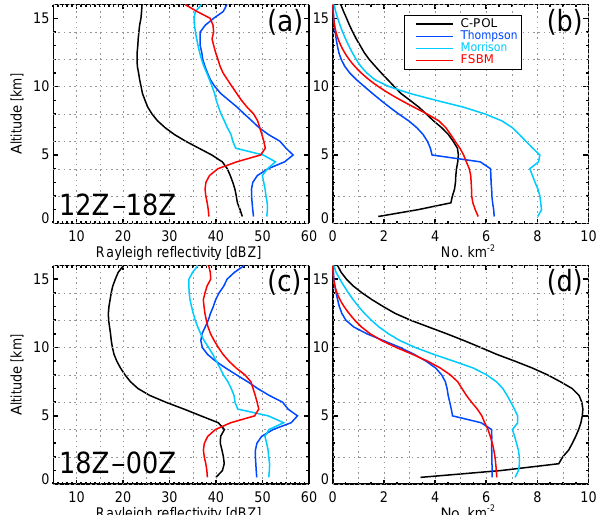
Figure 5. Rayleigh reflectivity 99th percentile profiles for the ob- served and simulated 18 February 2014 MCS case during (a) 12:00– 18:00UTC on 18 February and (c) 18:00UTC on 18 February to 00:00UTC on 19 February. Sample sizes normalized by do- main area are shown in (b) and (d) for 12:00–18:00 and 18:00– 00:00UTC, respectively. Only reflectivity values ≥ 5dBZ are in- cluded. Retrieved C-POL reflectivity is in black, Thompson in dark blue, Morrison in cyan, and FSBM in red.